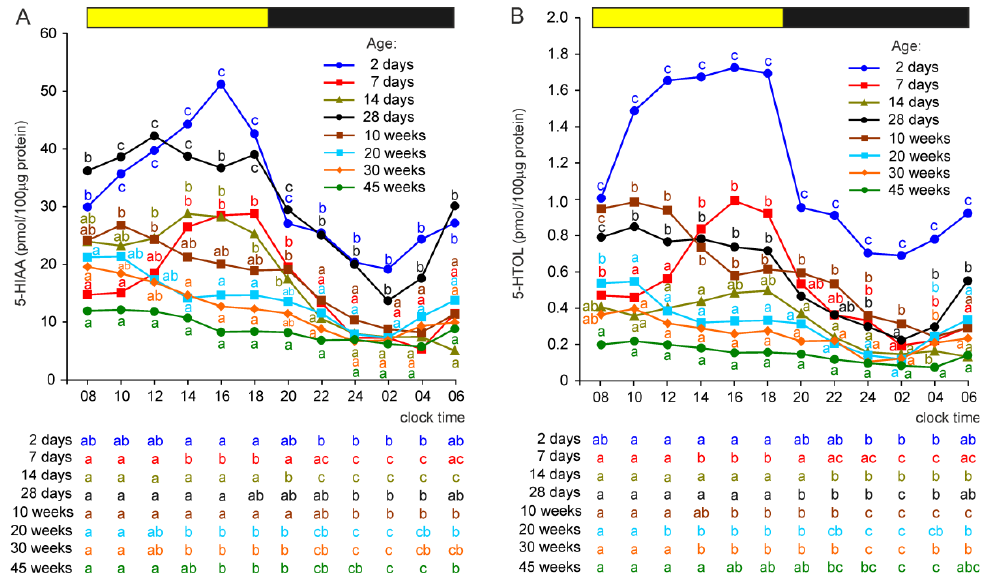
Figure 5. Concentrations (means) of 5-hydroxyindole acetic acid, 5-HIAA ( A ), and 5-hydroxytryptophol, 5-HTOL ( B ), in the pineal organs of turkeys at the ages of 2, 7, 14, 28 days and 10, 20, 30, 45 weeks. The horizontal bar represents the periods of light and dark phases of the daily cycle. The letters on the charts show differences between age groups at each time-point in Duncan’s test. The letters below the charts show differences between time-points within a group in Duncan’s test. The same letters indicate means which are not significantly different.